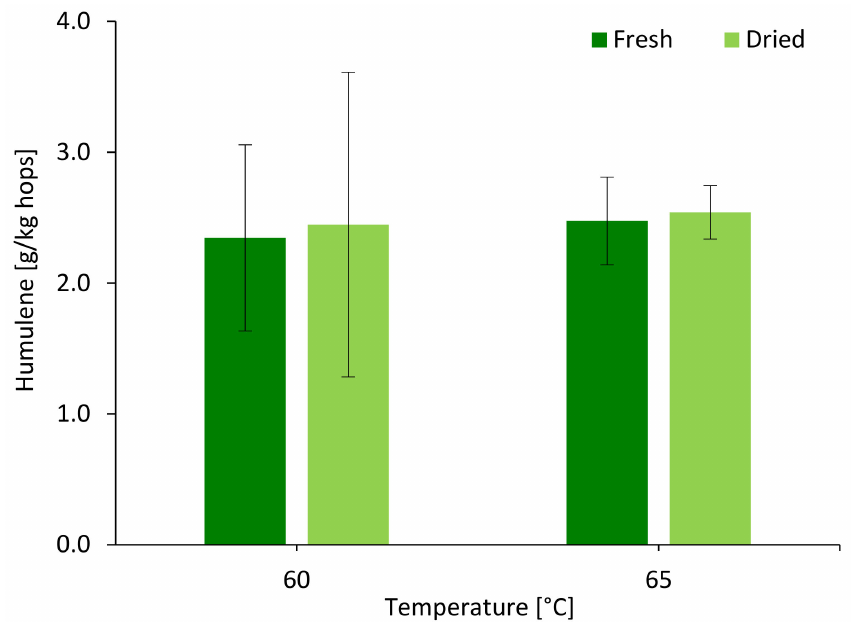
Figure 12. Results obtained from gas chromatography analysis for humulene in g / kg hops at 0 min and 210 min for hop cones dried at 60 ◦ C and 65 ◦ C at 0.35 m / s.